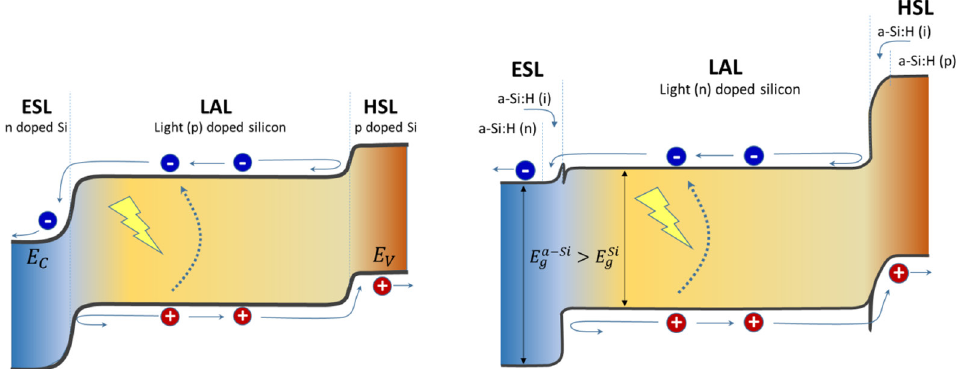
Fig. 7. – (a) Band profile of Passivated Emitter Rear Cell (PERC) based on homojunction silicon technology; (b) band profile of a heterojunction a-Si/c-Si solar